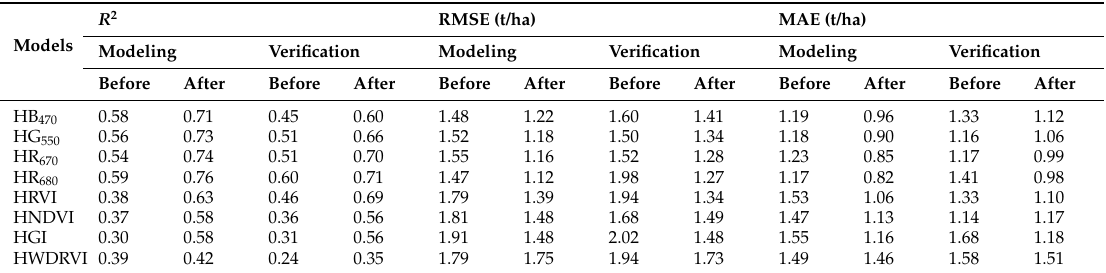
Table 6. Statistics of the coefficient of determination ( R 2 ), root mean square error (RMSE) and mean absolute error (MAE) of models in modeling and